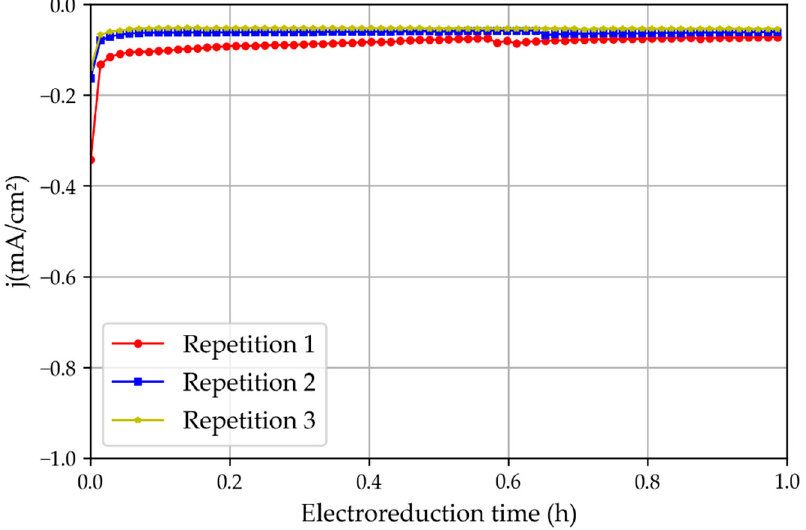
Figure 9. Three repetitions of the chronoamperometric test using new tin catalysts that had not been oxidated in the atmosphere and the 3D printed reactor.